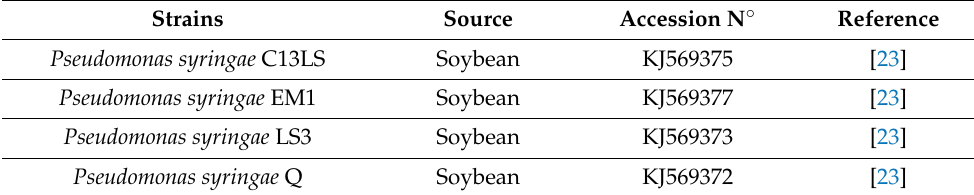
Table 1. Pseudomonas strains isolated from soybean fields in Argentina.